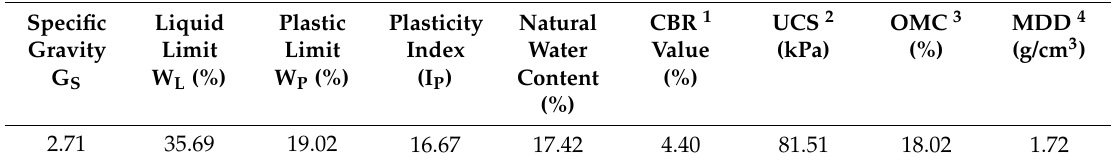
Table 1. The physical properties of loess sample.